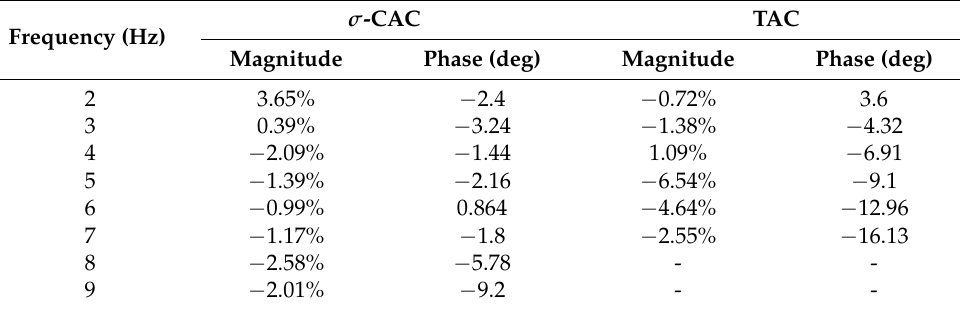
Figure 9. Results of σ -CAC at 9 Hz. ( a ) Trajectory tracking of σ -CAC; ( b ) position error of σ -CAC. Table 2. Comparison results of the two control